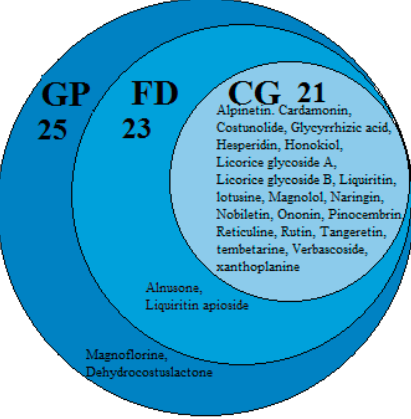
Figure 13. Distribution of 25 potential active ingredients in three diseases.